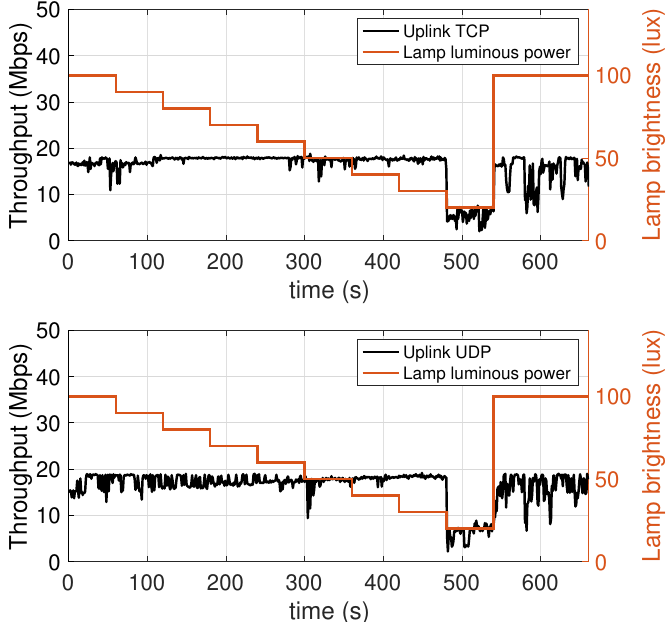
Figure 10. Uplink throughput with different lamp luminous power values. TCP (top chart) and UDP (bottom